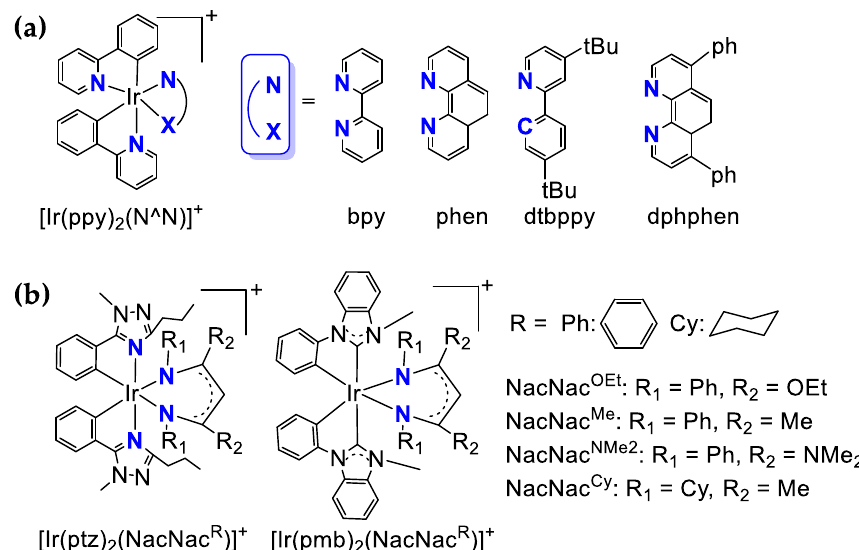
Figure 5. Chemical structures of the ( a ) [Ir(ppy) 2 (bpy)] + -based and ( b ) β-diketiminate-modified (NacNac) iridium photosensitizers and corresponding ligands in this review.